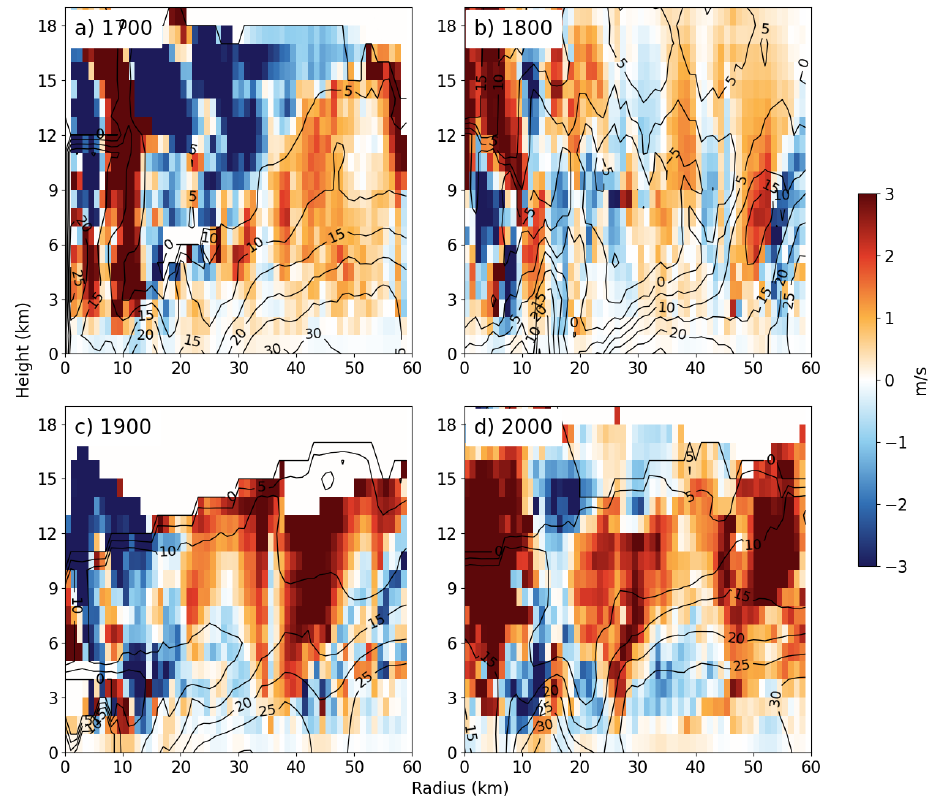
Figure 13. Variations of the vertical velocity (color shading) and reflectivity (black contour) azimuth means in the upwind of stratiform rainband at 270–340° with horizontal radius of 0–60 km outward from typhoon center with altitude at ( a ) 17:00, ( b ) 18:00, ( c ) 19:00 and ( d ) 20:00 UTC. The negative value of vertical velocity azimuth mean represents the downdraft and the positive value the updraft.